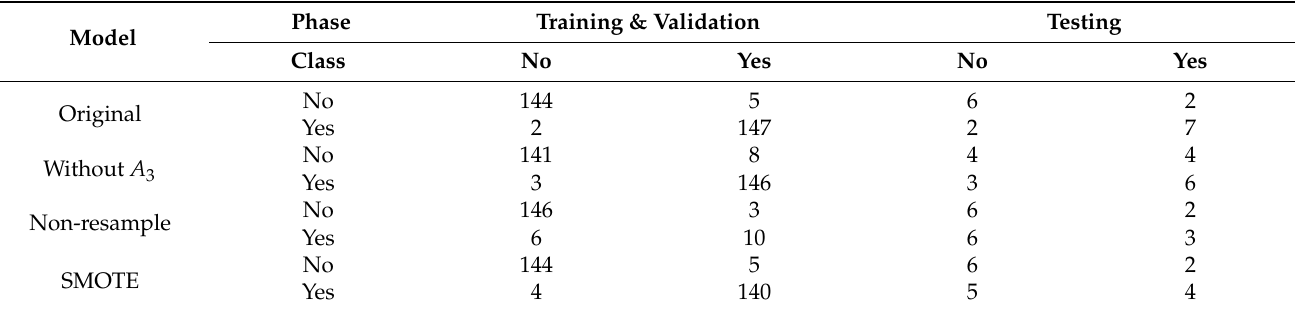
Table 15. Confusion matrix of prediction results of RF models in different